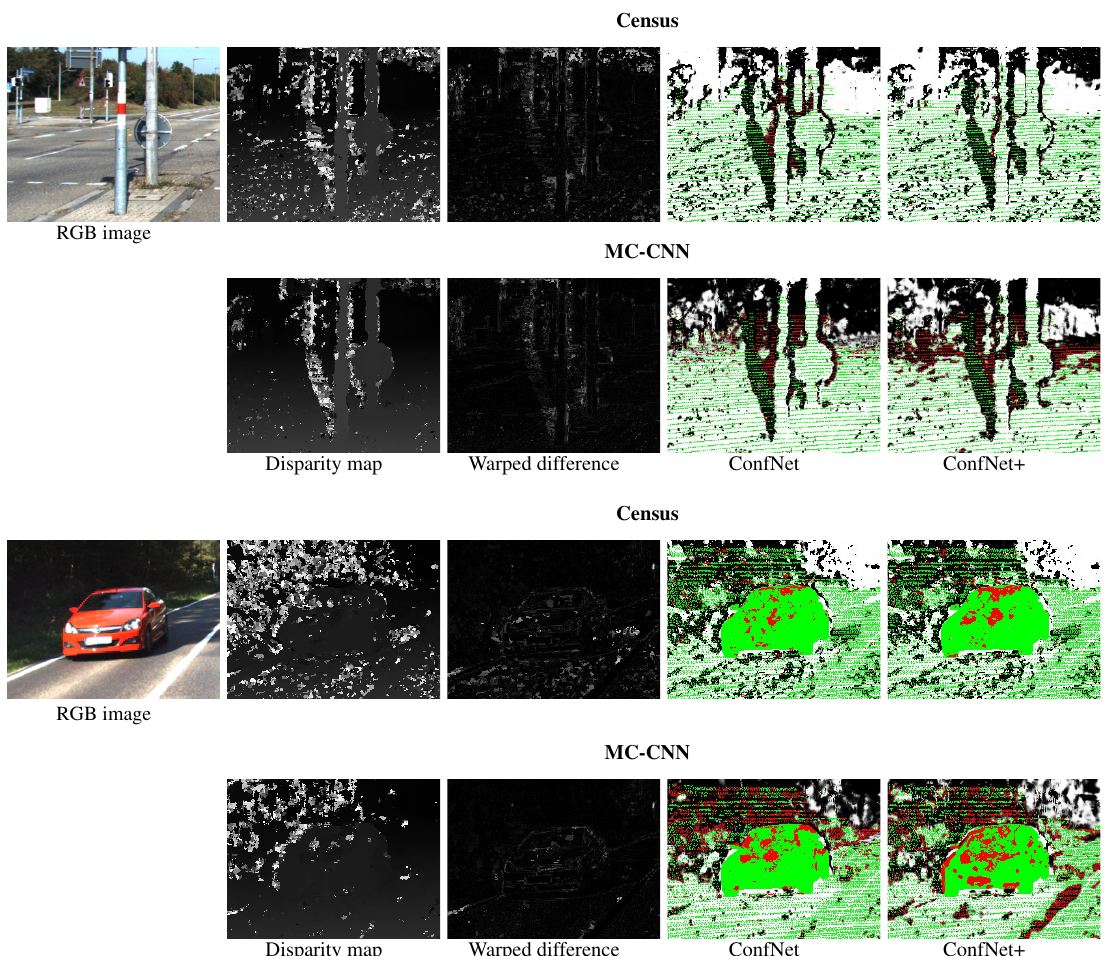
Figure 2. Qualitative evaluation of the impact of WD on the KITTI 2015 dataset (Menze and Geiger, 2015). Presented are a case of a noisy disparity map on the top row and an object with fine details and reflections in the bottom row, showing the respective RGB image, the disparity map, the warped difference, and the confidence maps computed with ConfNet and ConfNet+, respectively. The disparity map is based either on Census or on MC-CNN fast. A pixel is coloured in green if either the assigned disparity is correct and the confidence c ≥ 0 . 5 or if the disparity assignment is incorrect and c < 0 . 5 . All remaining pixels with available ground truth disparity are coloured in red, indicating an erroneous confidence prediction. Pixels without ground truth disparity are shown in grey shades, indicating a high confidence prediction in white and a low one in